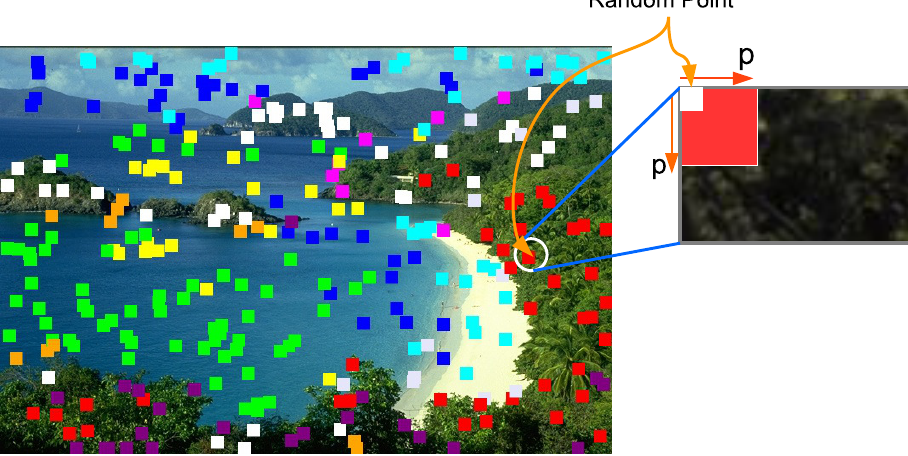
Figure 5. Image with random points, each one generating a neighborhood 10 × 10 size pixels.